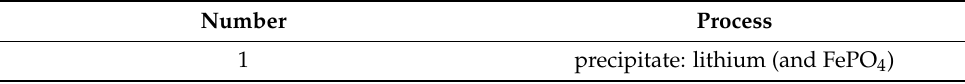
Table A21. Activities of the main application process “recycling”: recover